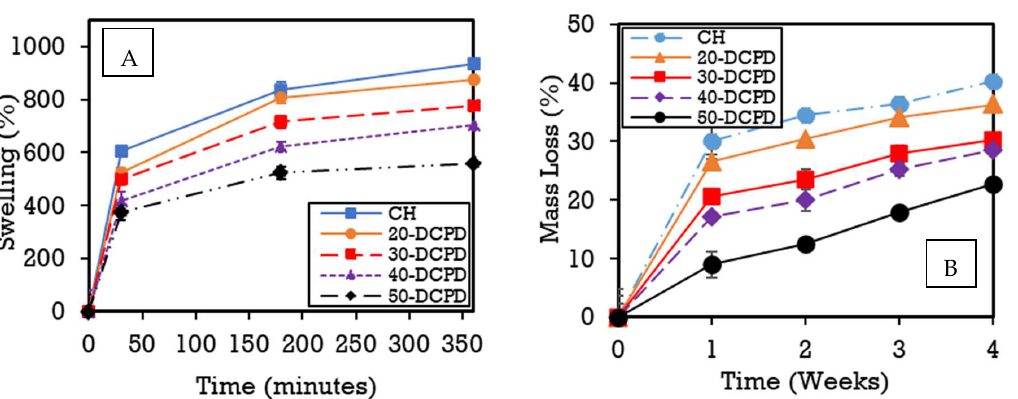
Figure 5. ( A ) Swelling kinetics of CH, 20, 30, 40 and 50-DCPD freeze-dried scaffolds submerged in phosphate saline buffer (pH 7.4) at a physiological temperature of 37 °C. Experiments were carried out in triplicates. ( B ) Degradation results for CH, 20, 30, 40 and 50-DCPD freeze-dried scaffolds submerged in phosphate saline buffer (pH 7.4) at a physiological temperature of 37 °C. The experiments were carried out in triplicate over a 4-week process.